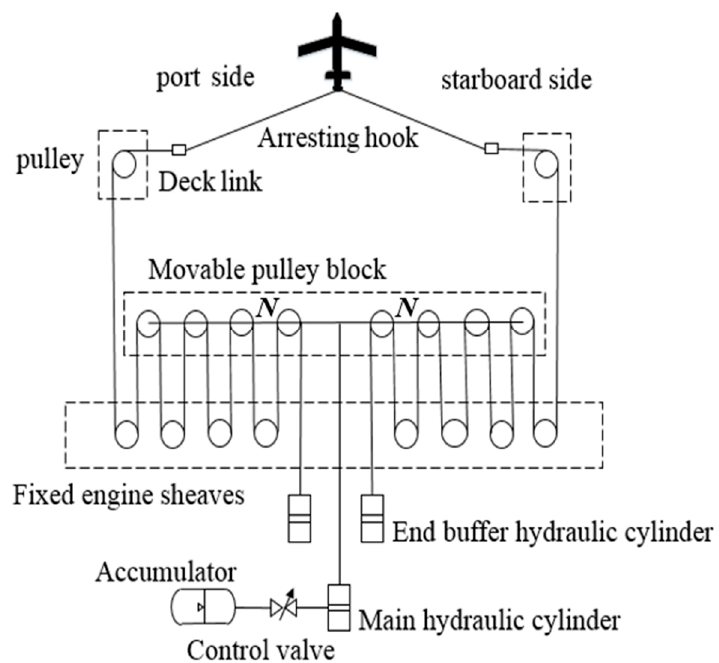
Figure 1. Schematic diagram of carrier aircraft landing and hanging cable.